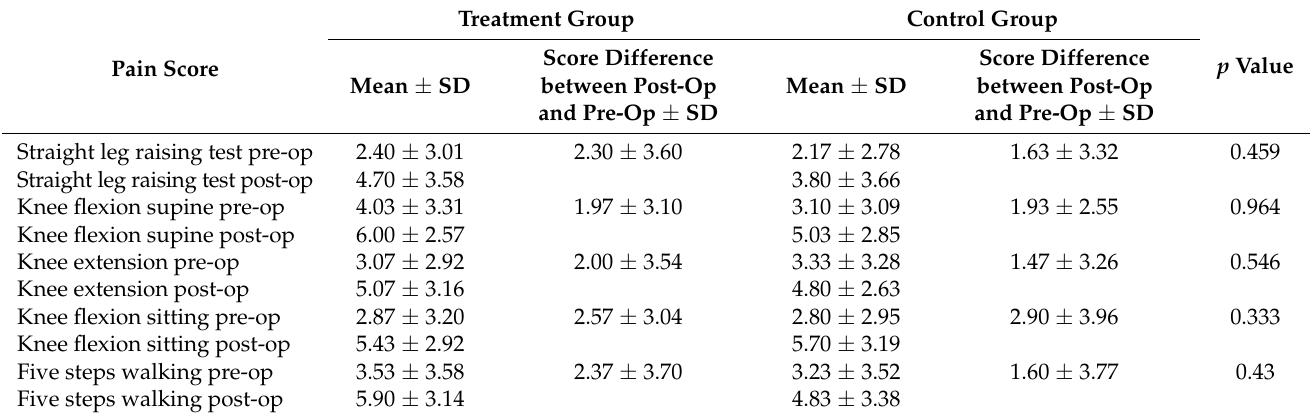
Table 2. Pre-operative (pre-op) and post-operative (post-op) mean ± standard deviation pain scores during five tasks with their mean difference (post-op minus pre-op scores) for both groups.